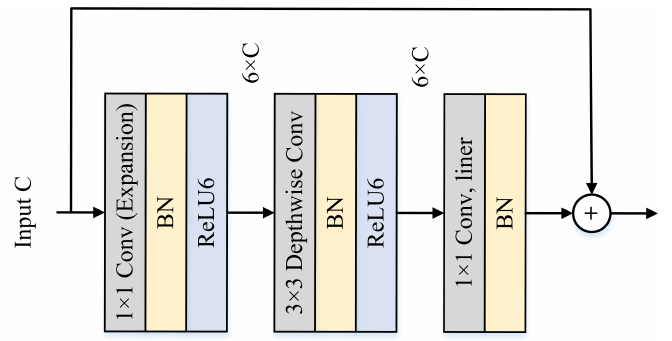
Figure 32. The bottleneck residual block of MobileNetV2. C is the number of channels, and expansion ratios are 6.